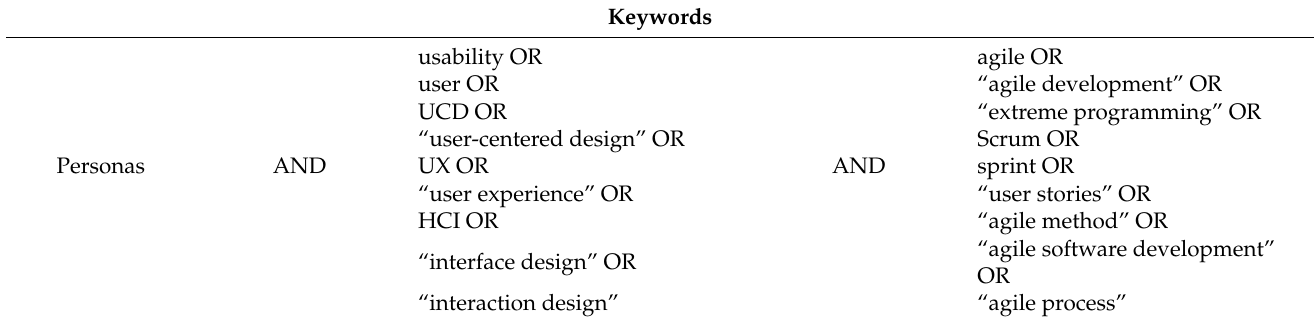
Table 3. Final search string.